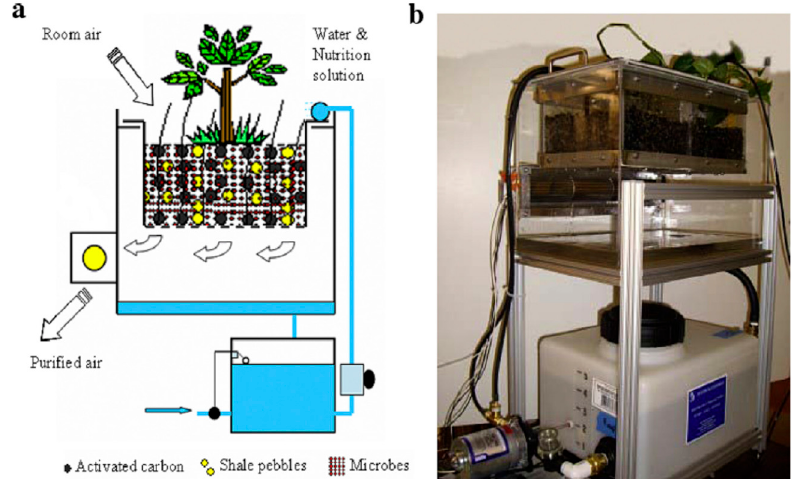
Figure 4. Dynamic botanical air filtration (DBAF) system: ( a ) schematics; ( b ) photo of the proto- type [133] .